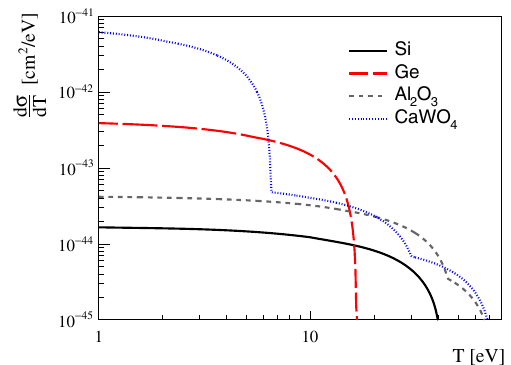
Fig. 2 Differential cross section as a function of recoil energy T for 51 Crneutrinos ontypicaltargetsusedincryogenicexperiments:silicon, germanium, sapphire and calcium tungstate. The nuclear form factor in Eq. 1 is assumed unitary